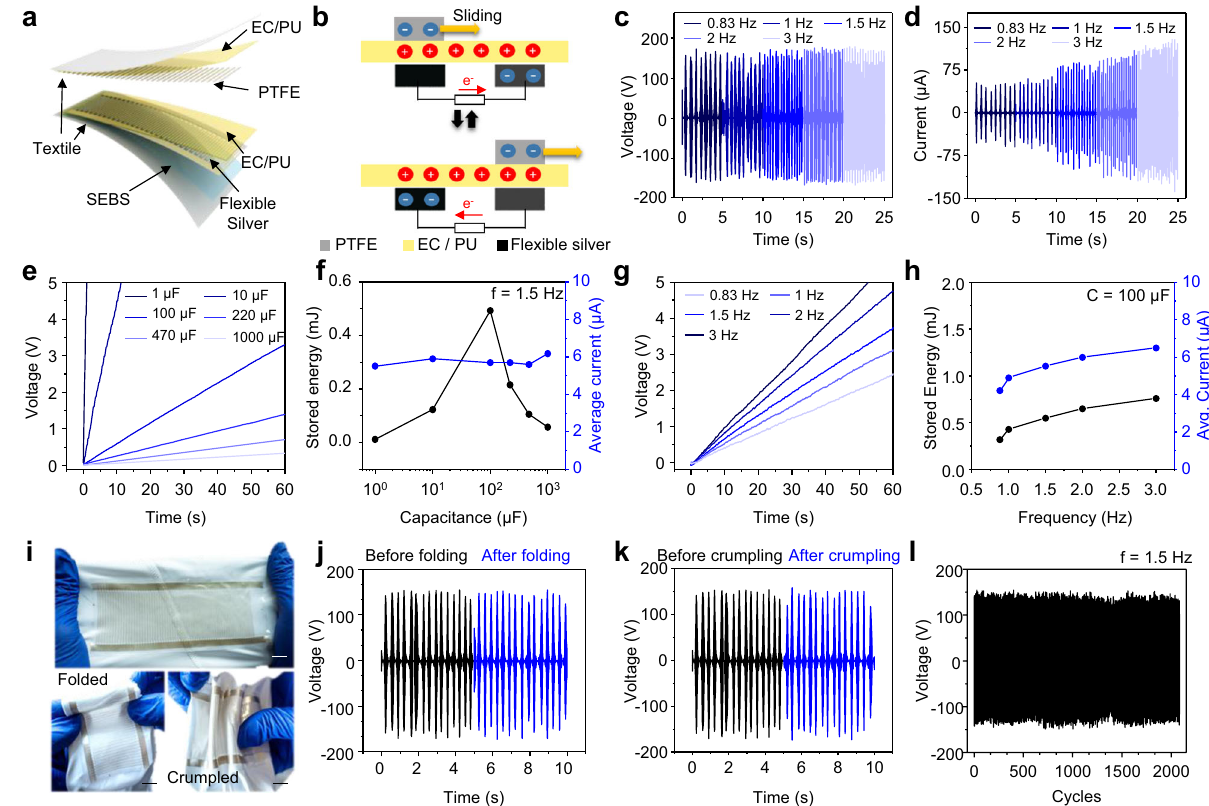
Fig. 2 Characterization of the performance of the TEG module. a Schematic image of the layer-by-layer composition of the textile-based TEG module composed of a PTFE-based mover (top) and an EC-PU-based stator (bottom). b The charge generation mechanism of the TEG module under in-plane friction between the mover and the stator. The unrecti fi ed output peak voltages ( c ) and peak currents ( d ) of the TEG at different sliding frequencies. The charging of commercial capacitors with difference capacitance at 1.5 Hz in a 60-s period ( e ) and the corresponding stored energies and equivalent average DC currents ( f ). The charging of 100 μ F capacitor at different frequencies in a 60-s period ( g ) and the corresponding stored energies and equivalent average DC currents ( h ). i Images of folded and crumpled TEG stator. Scale bar, 1 cm. The unrecti fi ed output peak voltages before and after 100 cycles of folding ( j ) and crumpling ( k ). l The long-term electrical signal from the TEG module under continuous sliding motions with the frequency of 1.5